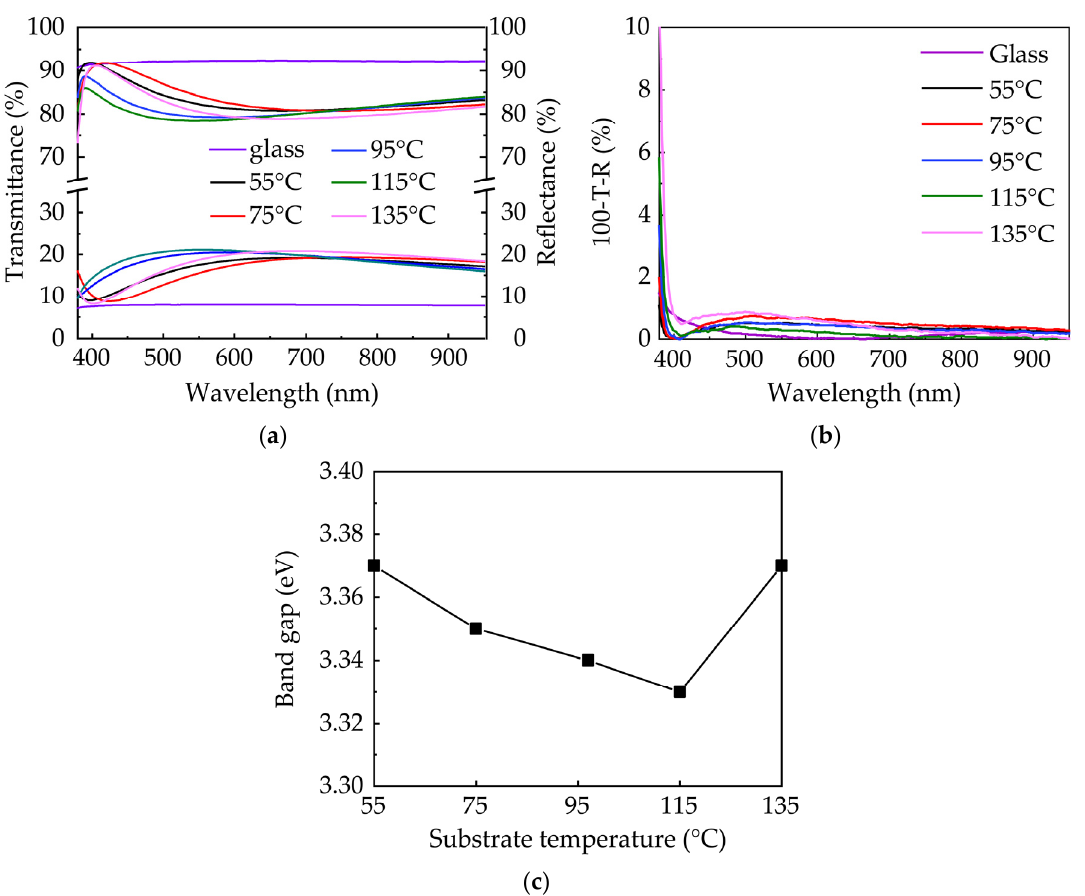
Figure 3. ( a ) Transmittance spectra and reflectance spectra; ( b ) optical losses; and ( c ) optical band gaps ( E g ) of sALD-ZnO films with varying substrate temperatures.